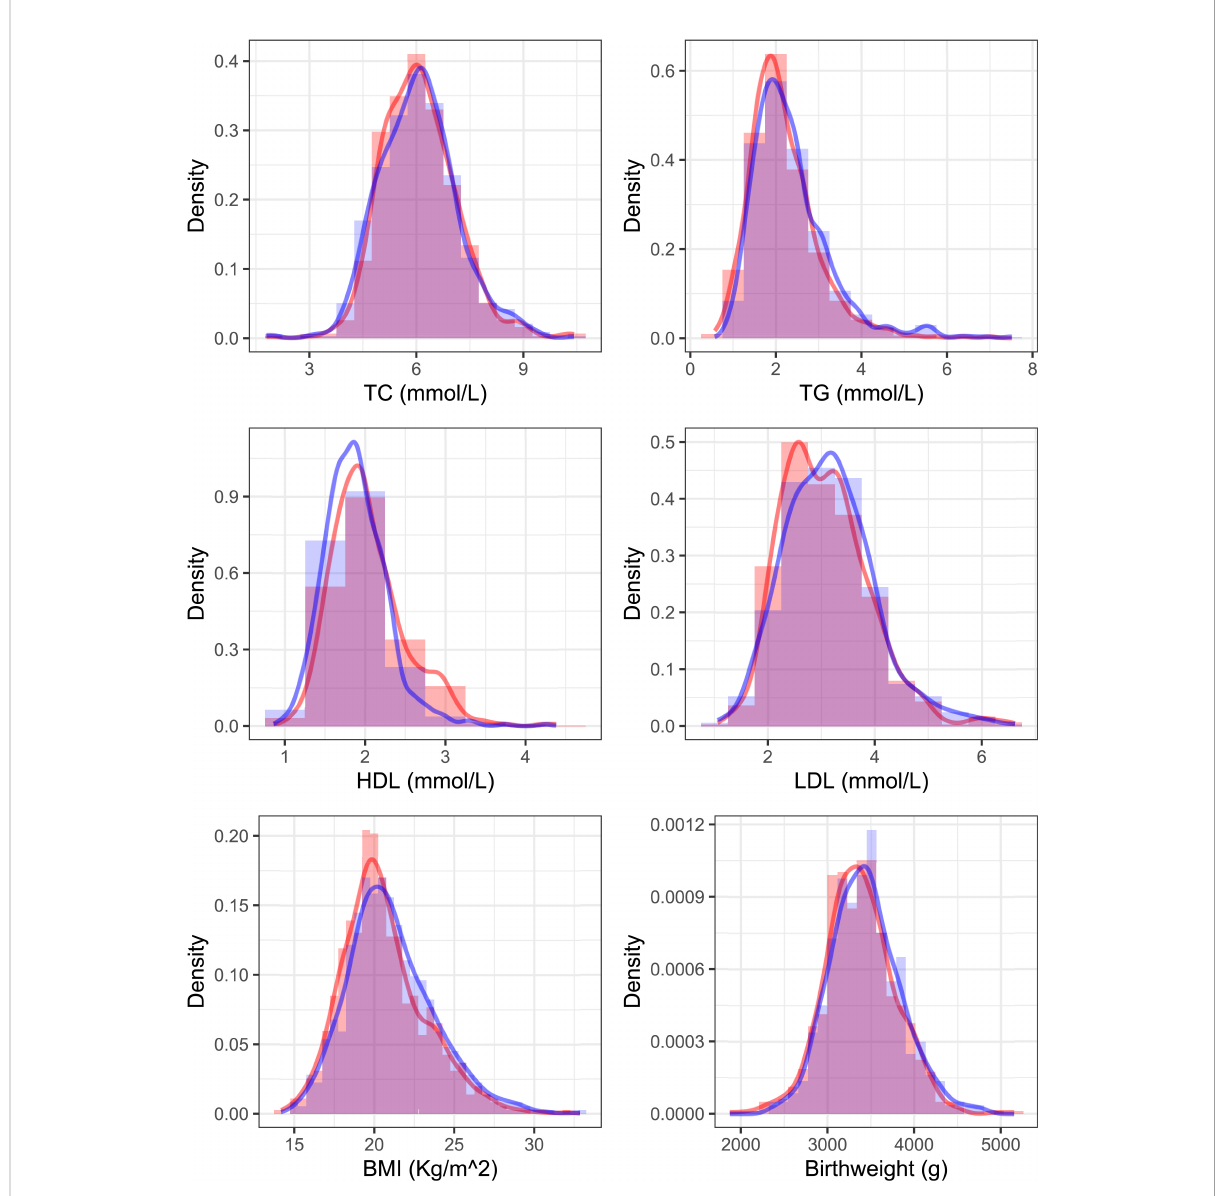
FIGURE 1 Distribution of 2 nd -trimester serum lipids and birthweight of the fi rst and second pregnancy. The red color shows the distribution curve in an older sibling and blue shows the next youngest